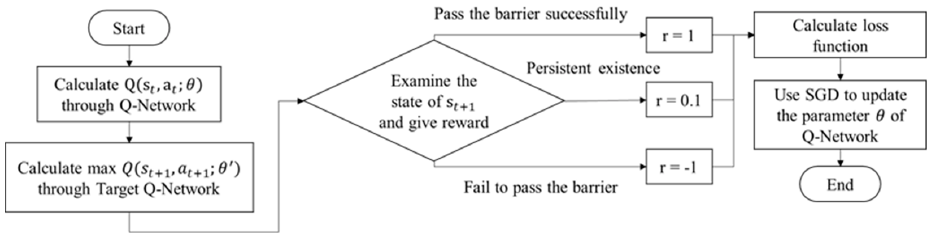
Figure 13. Flowchart of the update stage.